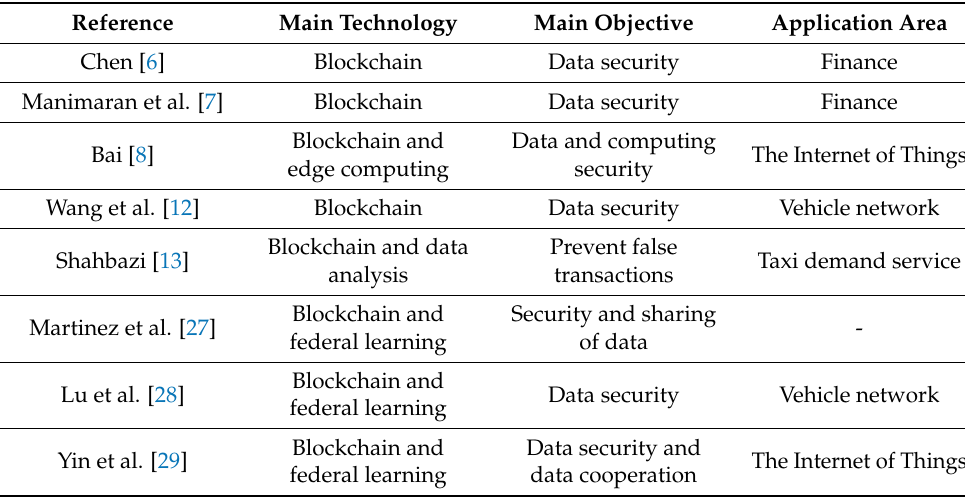
Table 1. Related literature comparison